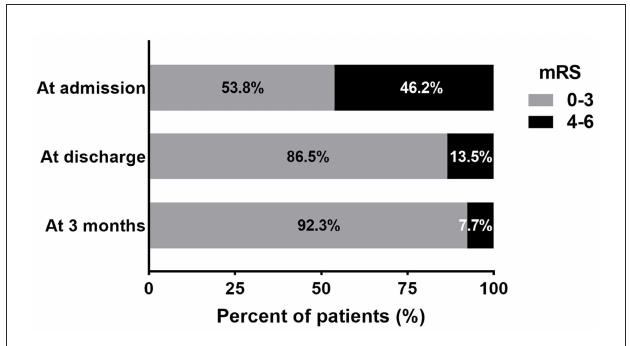
FIGURE2 The bar diagram presents the distribution of patients according to the mRS score at admission, discharge, and 3 months following surgery.